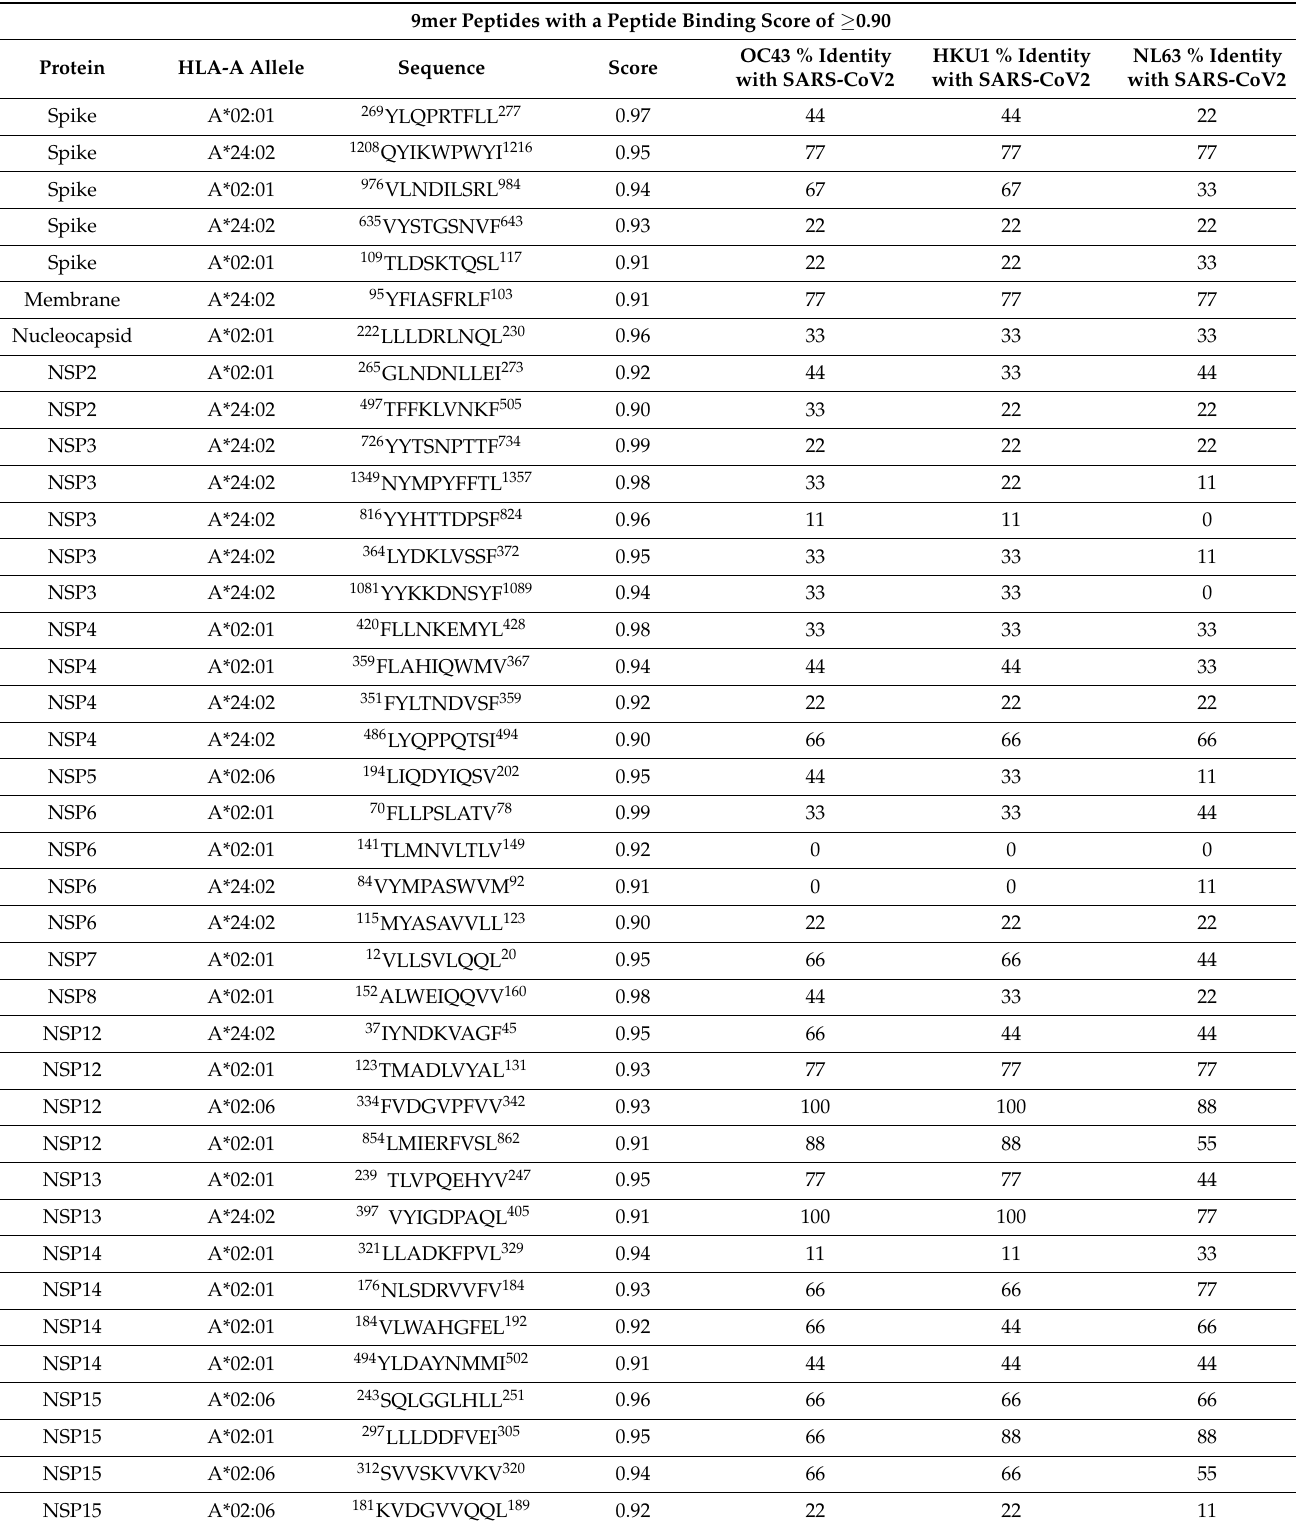
Table 1. Predicted CD8 + epitopes of the SARS-CoV2 virus restricted through HLA-A alleles. 9mer Peptides with a Peptide Binding Score of ≥